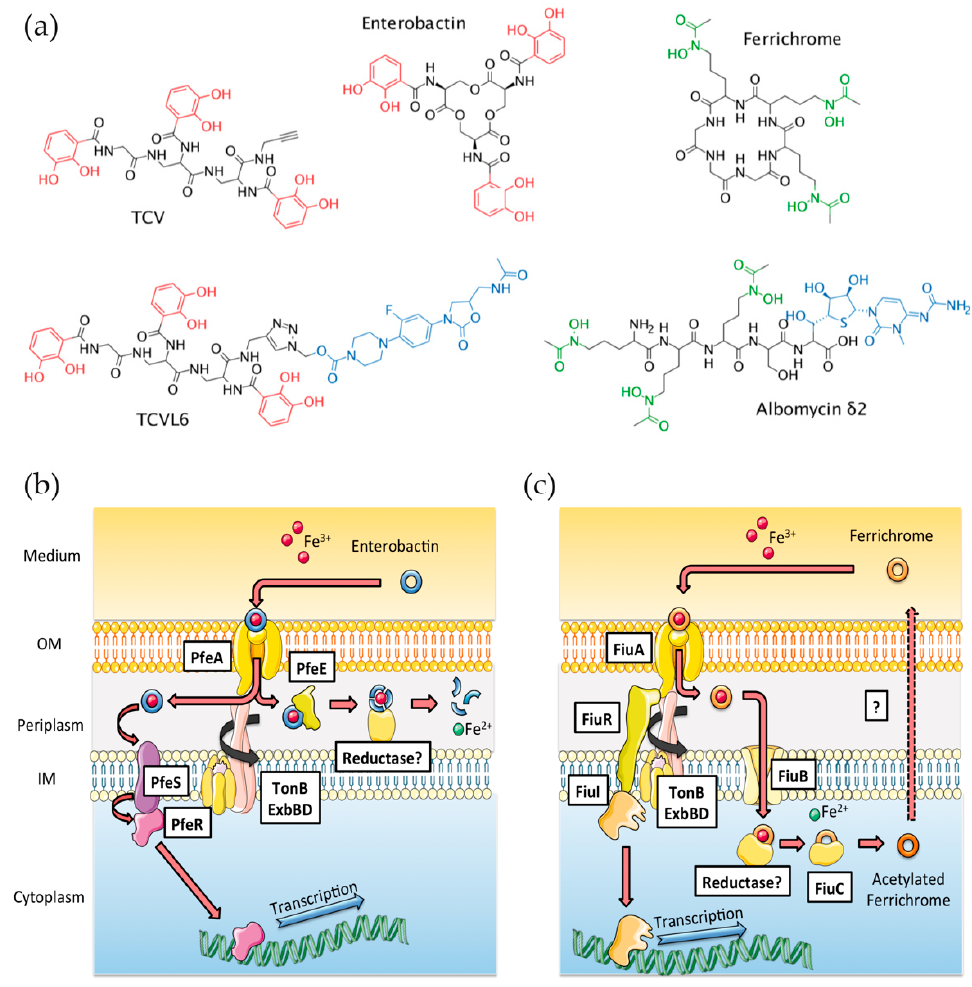
Figure 1. ( a ) Structure of ferrichrome (FERRI), albomycin (ALBO), enterobactin (ENT), tris-catechol vector (TCV), and tris-catechol-linezolid vector (TCVL6). ( b , c ) ENT- and FERRI-dependent iron-uptake pathways in P. aeruginosa , respectively. FERRI and ENT loaded with iron are recognized